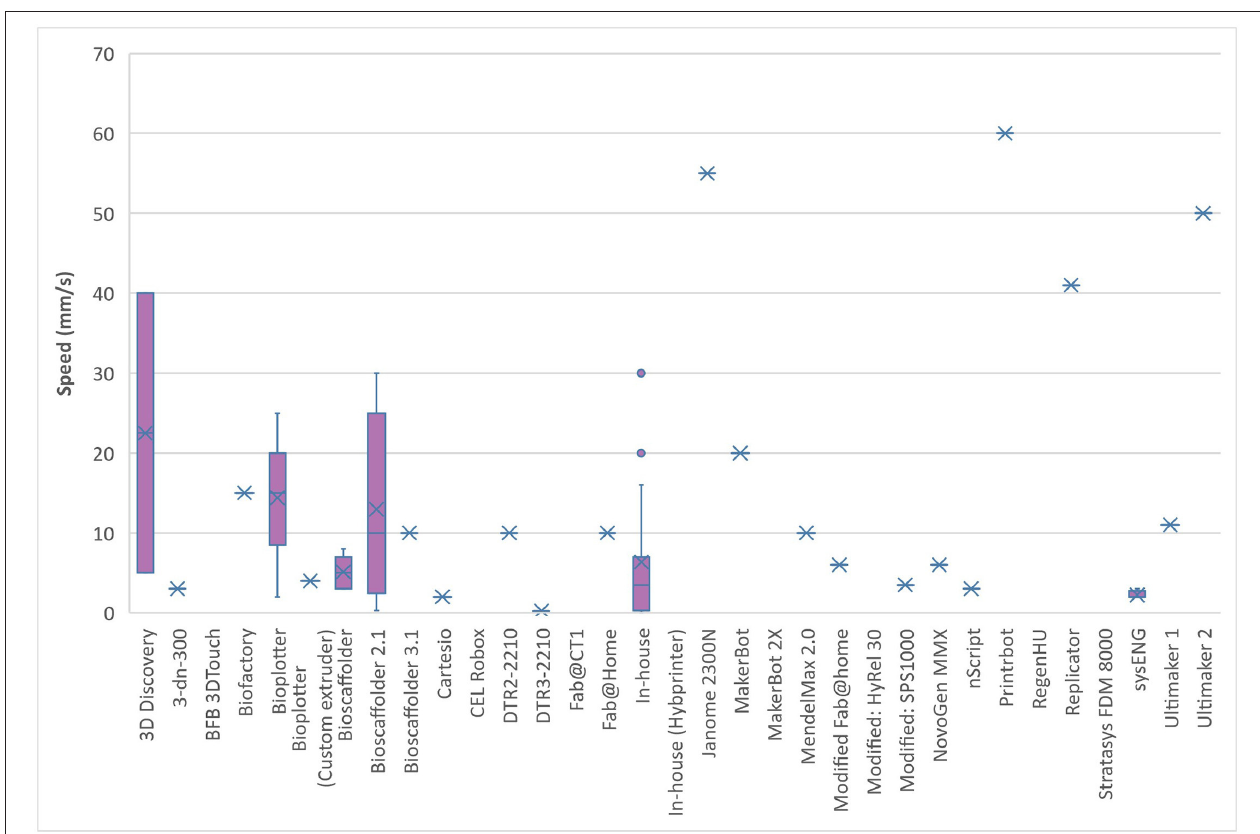
FIGURE 7 | Bioprinting speed for different models of commercial